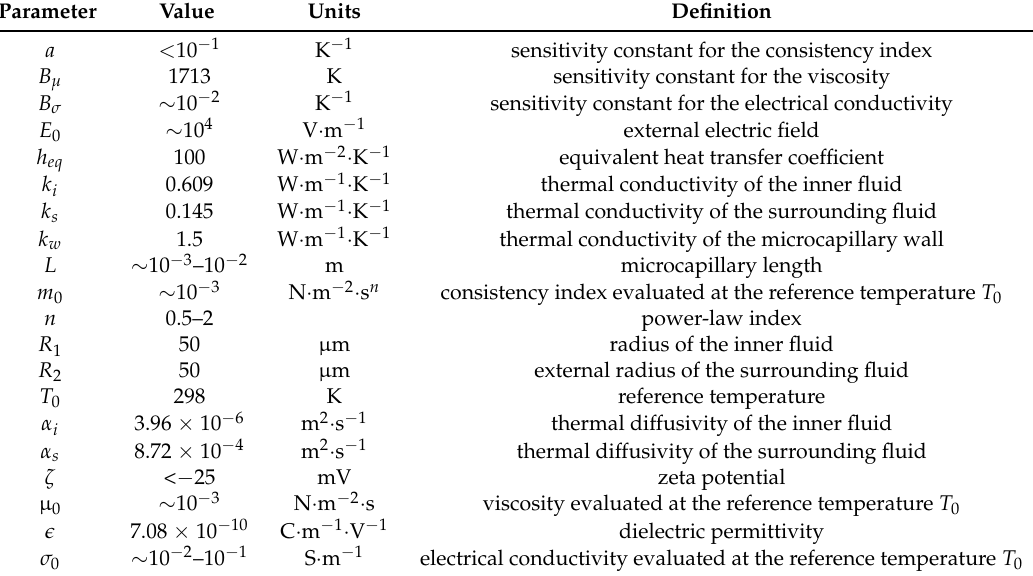
Table 1. Physical and geometrical parameters used for estimating the dimensionless parameters used in the present